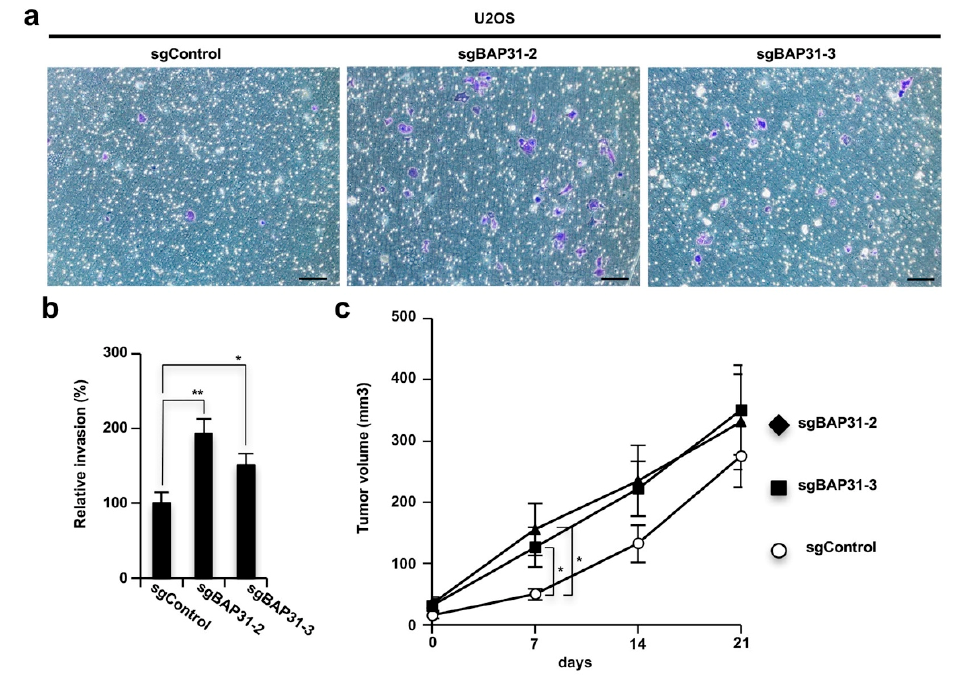
Figure 4. BAP31 deficiency leads to stimulation of tumor invasion and growth in vitro and in vivo. ( a , b ) BAP31 deficiency stimulates invasion activity in U2OS cells. U2OS cells subjected to BAP31 knockout via the CRISPR-Cas9 system (sgControl, sgBAP31-2, and sgBAP31-3) were seeded onto a transwell chamber coated with Matrigel. After 24 h, invader cells were stained with crystal violet (scale bar, 100 µm) (a). Stained crystal violet was extracted and measured at 570 nm (b). Data are